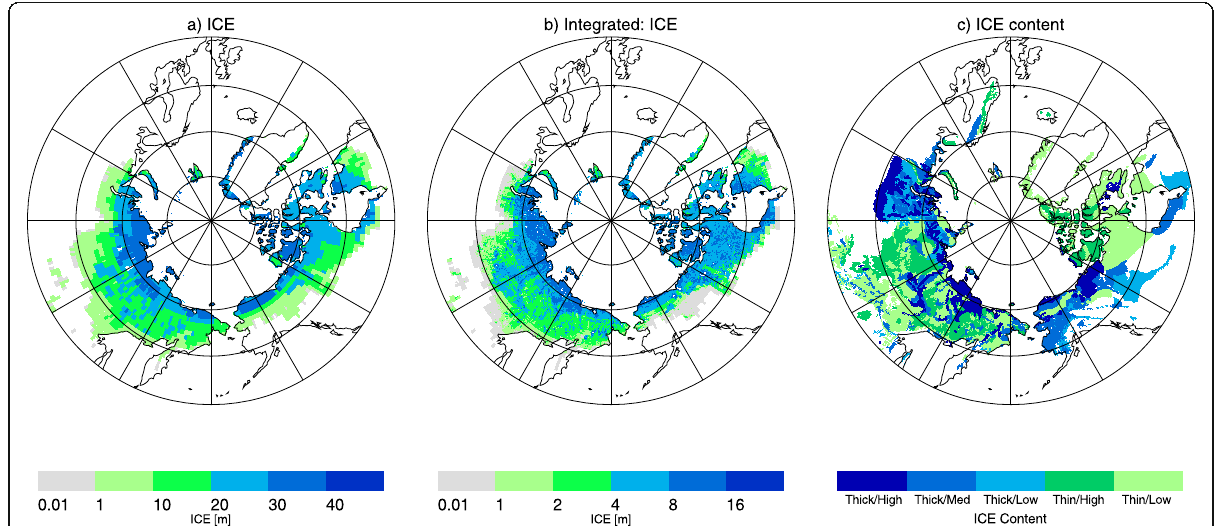
Fig. 6 Circum-Arctic maps of ICE distribution. a The simulated ICE at 1° resolution. b The integrated ICE map at 0.2° resolution. c Map of ground ice content taken from the IPA map (Brown et al.